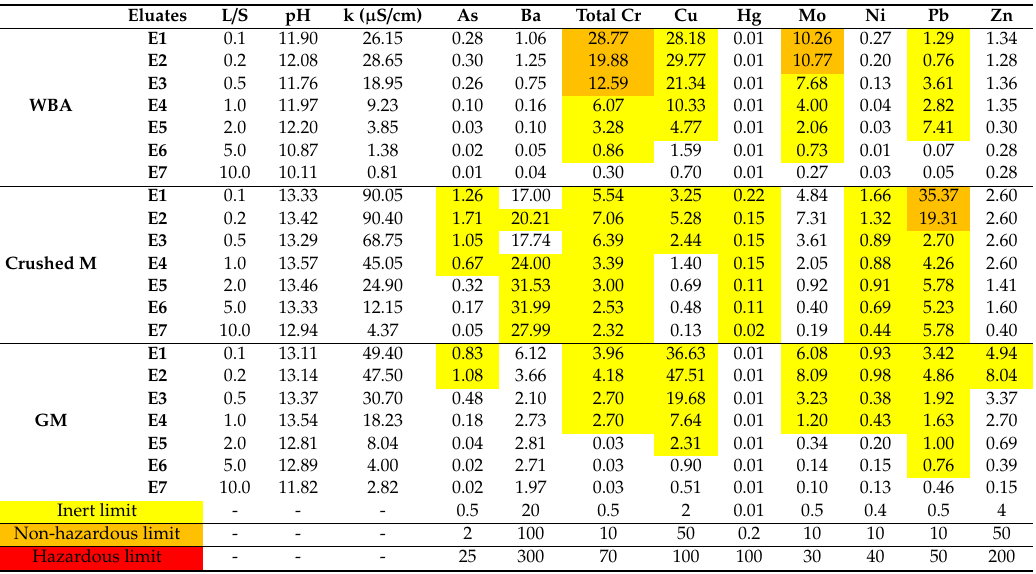
Table 5. Percolation column tests (CEN / TS 16,637) results for the WBA, crushed M and GM. The metal(loid)s units are mg · kg − 1 . (Red color, orange color and yellow color for values above hazardous, non-hazardous and inert limits, respectively, according to Catalan Order Number 5370 / 30.4.2009).